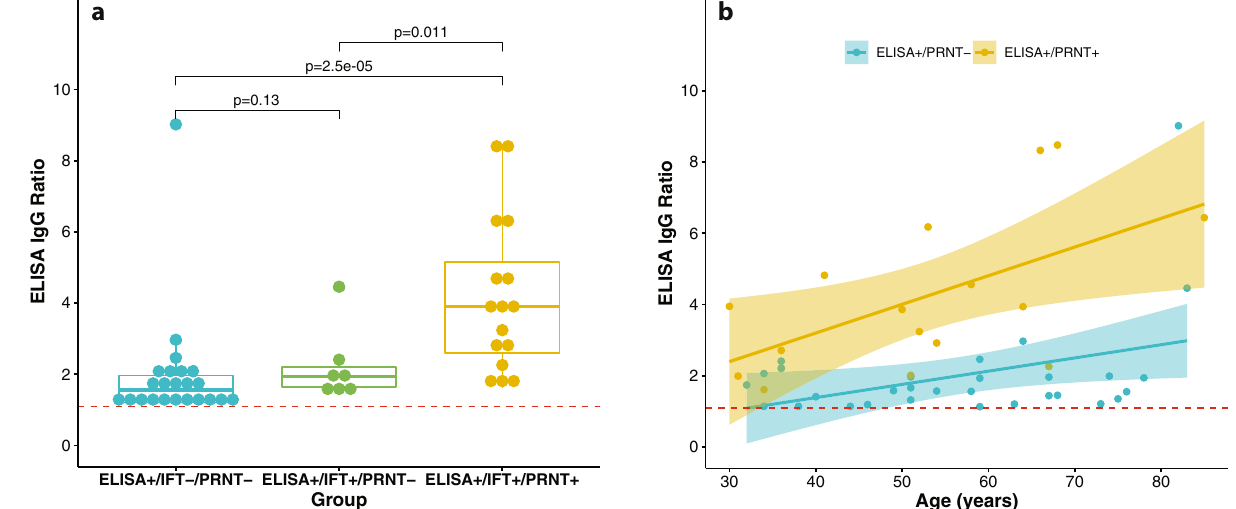
Fig. 3 Relation between IgG response and neutralizing antibodies. a Individuals with neutralizing antibodies had a signi fi cantly higher IgG antibody response as represented by the ELISA IgG ratio (a minus or a plus sign indicates a negative or positive test result, respectively). Each individual measurement is represented by one dot. The red dotted line indicates the threshold for a positive ELISA result. The box-plots indicate the medians (bold horizontal lines) and interquartile ranges (box boundaries), while the whiskers represent 1.5× interquartile ranges. Sample sizes: 23 ELISA + /IFT − /PRNT − , 7 ELISA + /IFT + /PRNT − , and 17 ELISA + /IFT + /PRNT + . P -values were obtained by the two-sided non-parametric Wilcoxon test. b Only in the ELISA + /PRNT + subgroup there was a signi fi cantly higher IgG response with increasing age. The shaded areas around the regression lines represent the 95% con fi dence intervals of the mean. The red dotted line indicates the threshold for a positive ELISA result. Please refer to the main text for further details. IFT immuno fl uorescence test, PRNT plaque reduction neutralization